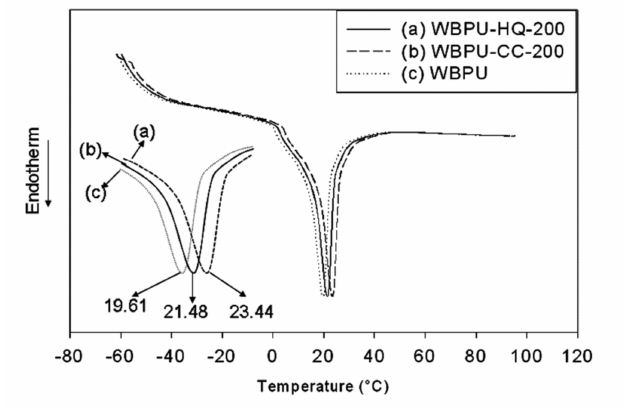
Figure 7. Typical DSC thermograms of WBPU.